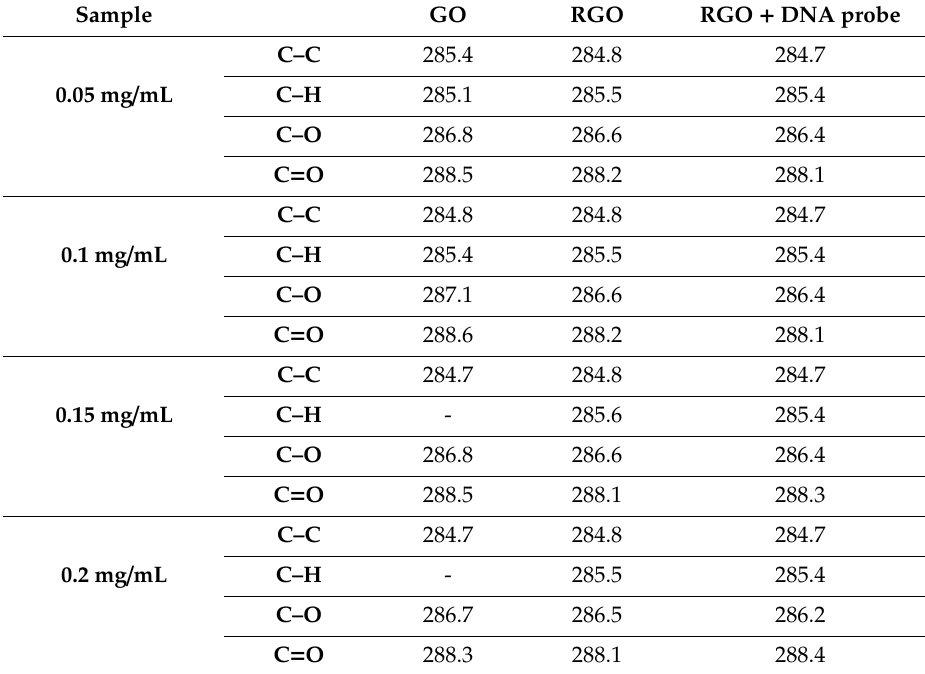
Table 2. Binding energies of specific bonds existing in graphene oxide, reduced graphene oxide, DNA probe immobilized on RGO, and DNA probe on a plastic substrate (values for DNA probe: C–C, 284.7; C–O, 286.2; C = O, 287.8).